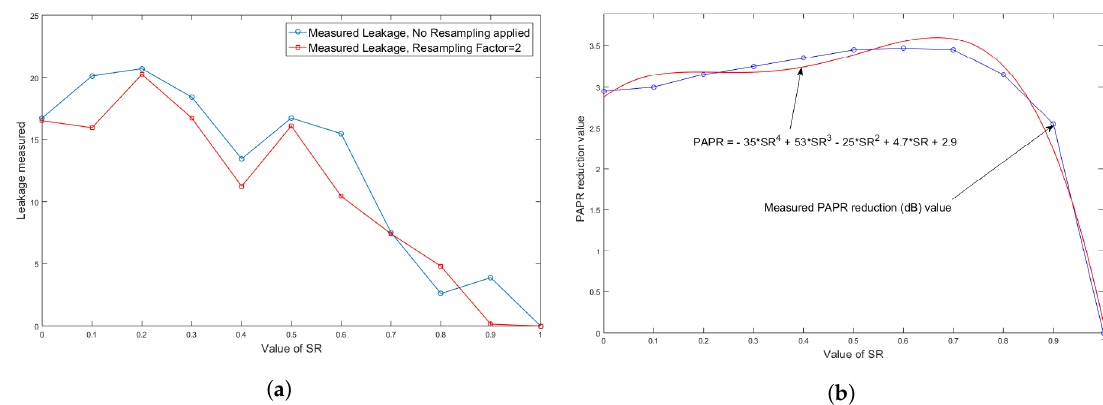
Figure 14. ( a ) Leakage behaviour versus SR. ( b ) PAPR reduction versus SR, and mathematical